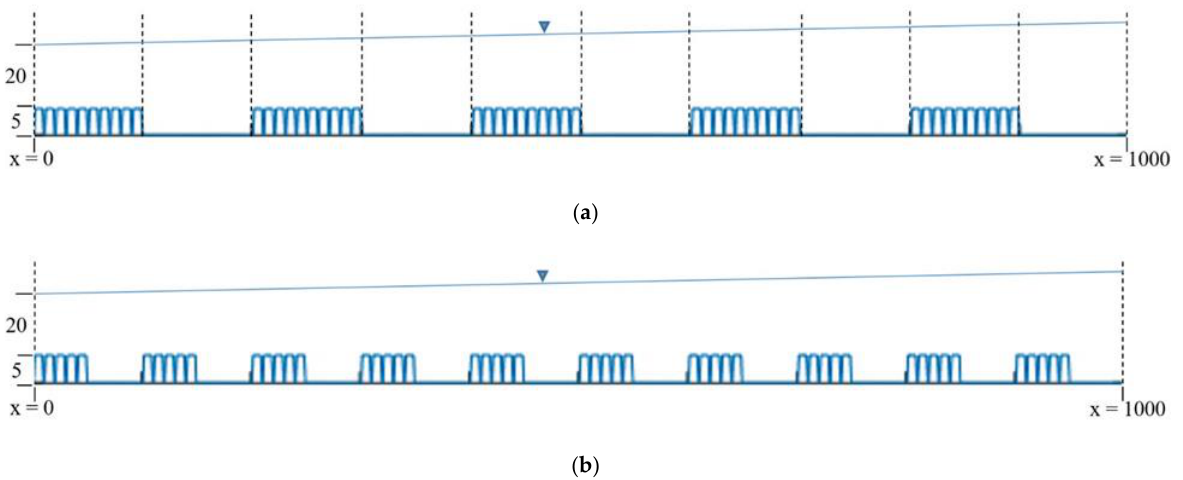
Figure 7. Streambed setups with variation in the extent of gravel and sand portion. Models’ setups used for the analysis are zgst5 × 10-5 ( a ), zgst5 × 10-10 ( b ). All units are in mm.